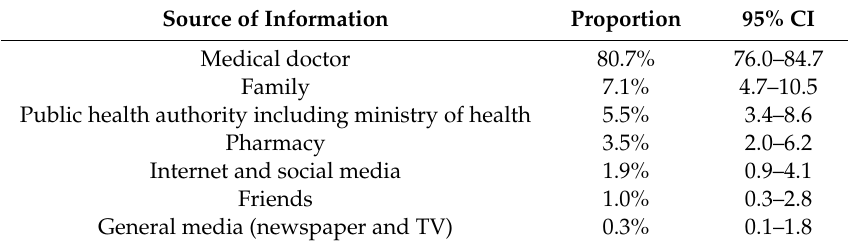
Table 7. Most common trusted sources of information ( n =